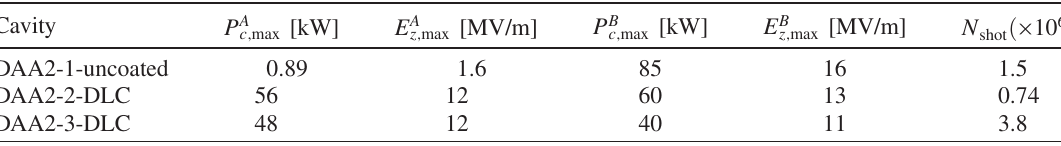
TABLE III. The peak stored power P Fig. 9. The number of shot N the sample shots.